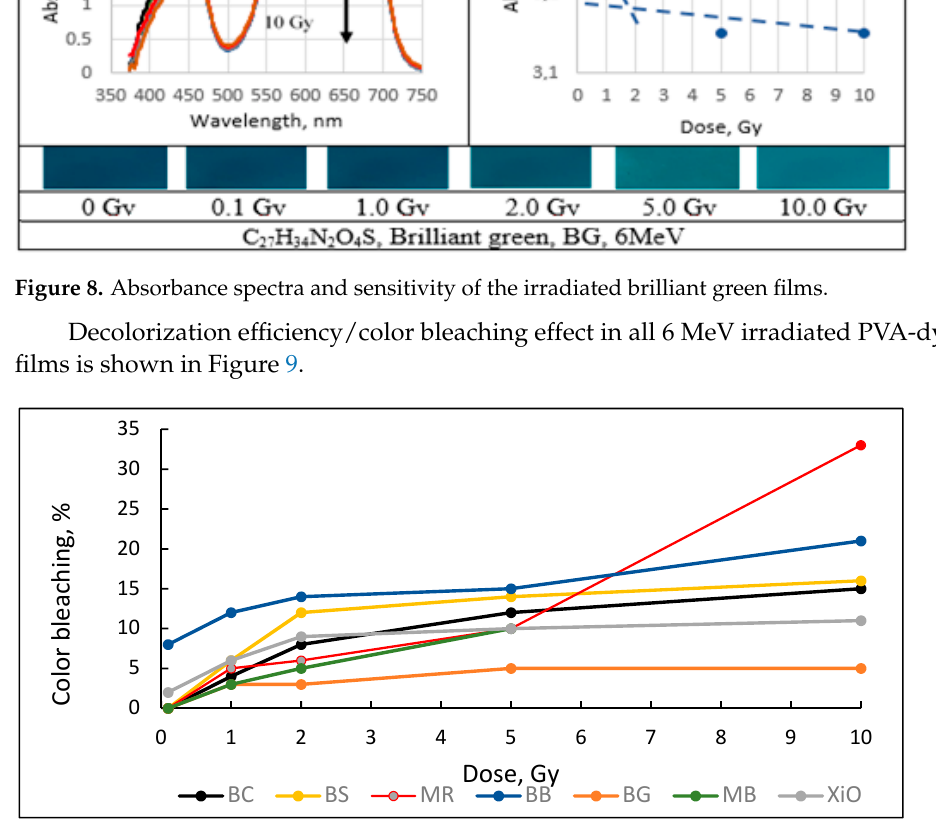
Figure 9. Color bleaching effect in irradiated investigated PVA-dye films. (Dose axis starts from 0.1 Gy.)